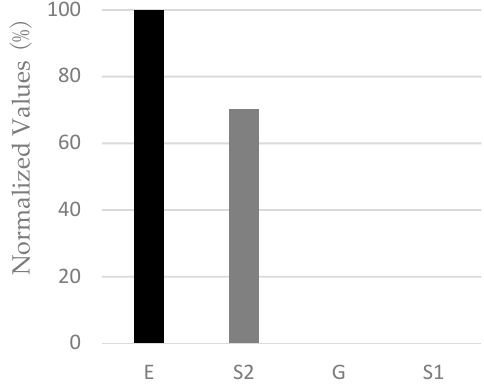
Figure 3. Interval scaled and normalized PWCT results of subjects (n = 19) for four insoles (a higher value stands for greater comfort).